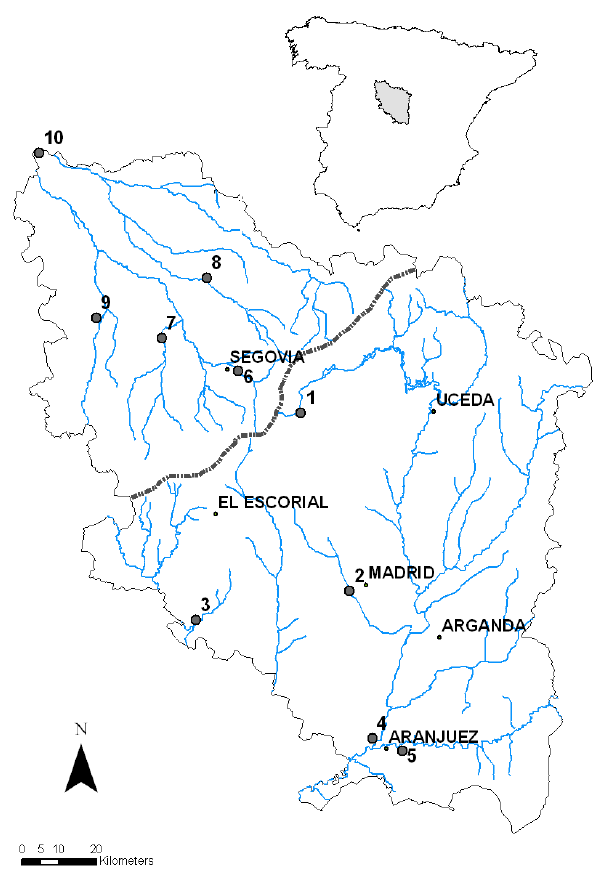
Fig. 1. Map of the study area, corresponding to the geographic region covered by the analysed documents. The Duero river basin is located to the north, and the Tagus river basin is located to the south. The extent of the map is based upon the administrative borders of Madrid and Segovia. Broken line=Spanish Central System divide; numbers=gauging